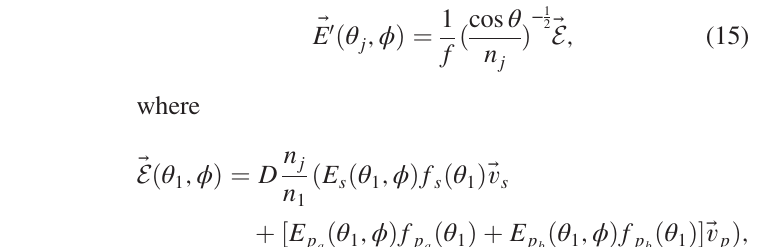
FIG. 2. The five cases corresponding to different experimental conditions, numbered from (i) to